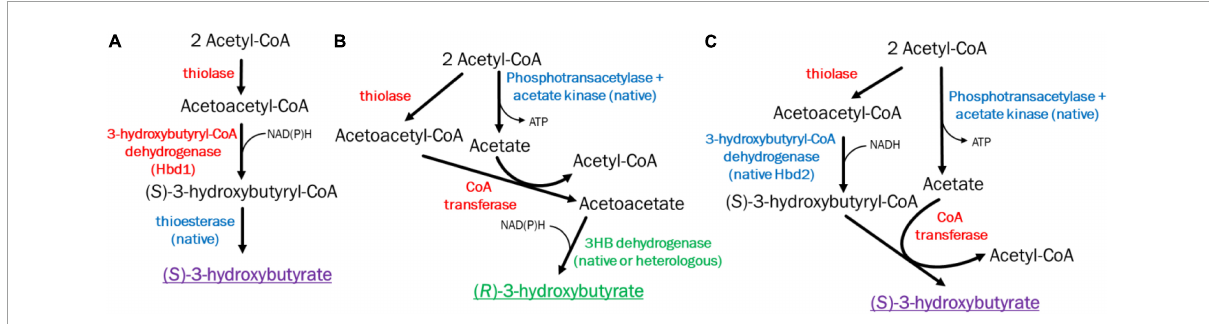
FIGURE1 Pathways and enzymes for acetogenic 3HB production. (A) ( S )-3-Hydroxybutyrate production pathway via Hbd1. (B) ( R )-3-Hydroxybutyrate production pathway via CoA transferase/3Hbdh. (C) New ( S )-3-Hydroxybutyrate production pathway via CoA transferase Hbd2. Heterologous enzymes in red, native enzymes in blue, native/heterologous R -3HB enzymes in green. S -3HB in